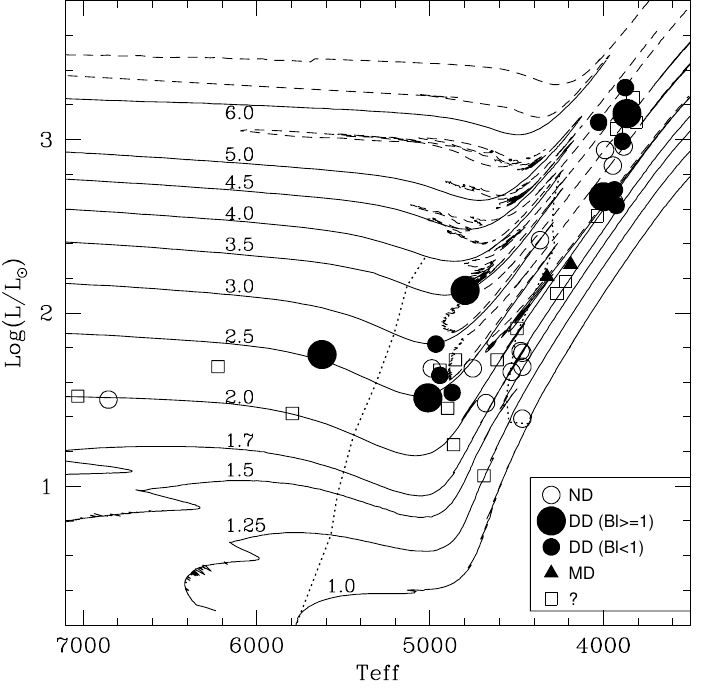
Figure 2. Magnetic field detections along the giant branches, according to Konstantinova-Antova et al., 2014 [21]. The dashed lines indicate the beginning and end of the first dredge-up phase. Apart from recent Hertzsprung Gap crossers on the foot RGB there is a second concentration or strip on the mid